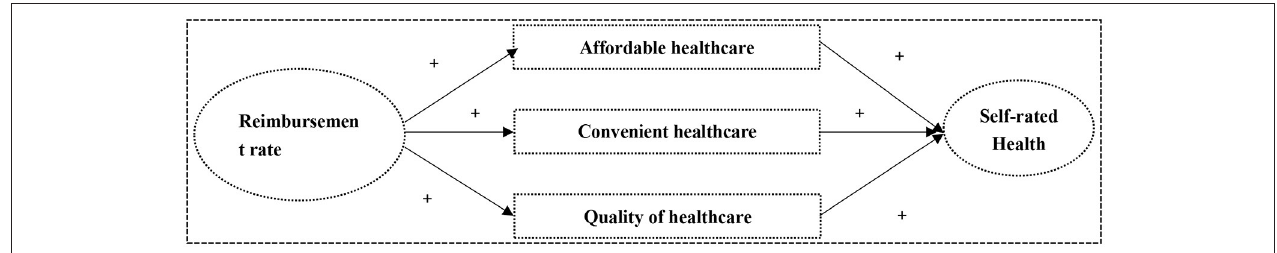
FIGURE 1 | The NRCMS’ reimbursement rate impacts the self-rated health among rural middle aged and elderly people through local medical service